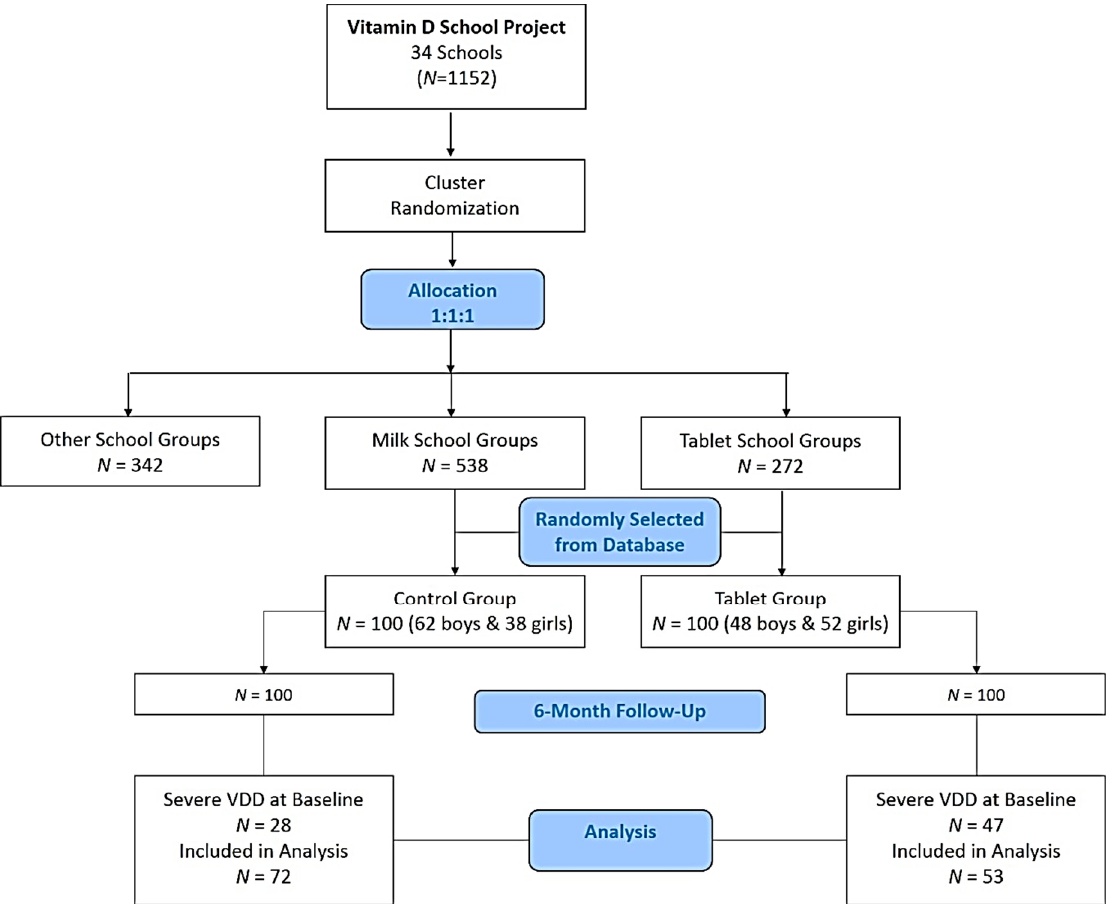
Figure 1. Study flowchart. VDD, vitamin D deficiency.